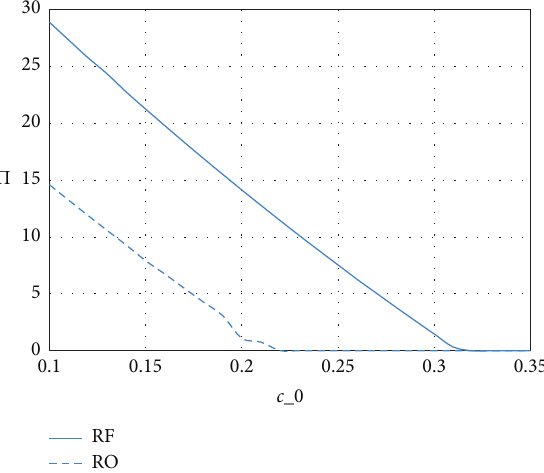
Figure 3: Impact of initial value of unit production cost on re- tailer’s